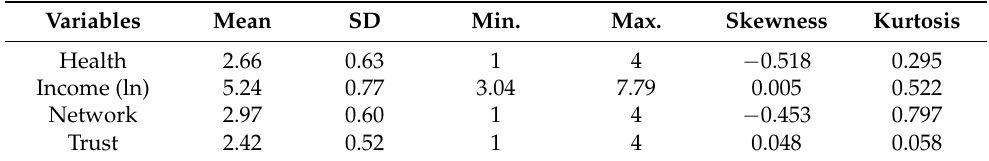
Table 2. Characteristics of the major variables.